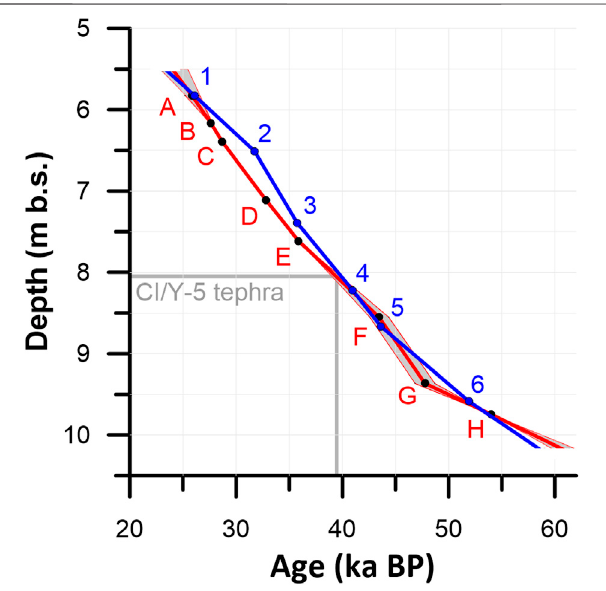
FIGURE 7 | Age models derived from RPI (blue) and magnetic susceptibility/NGRIP correlation (red). Because different ages arise from the correlation of most tie points by magnetic susceptibility correlation, the mean value is given by the red line framed by a shaded area con fi ned by the minimum and maximum ages. This area does not represent the con fi dence interval. The tephra layer is indicated in grey at 39.85 ka (Giaccio et al.,